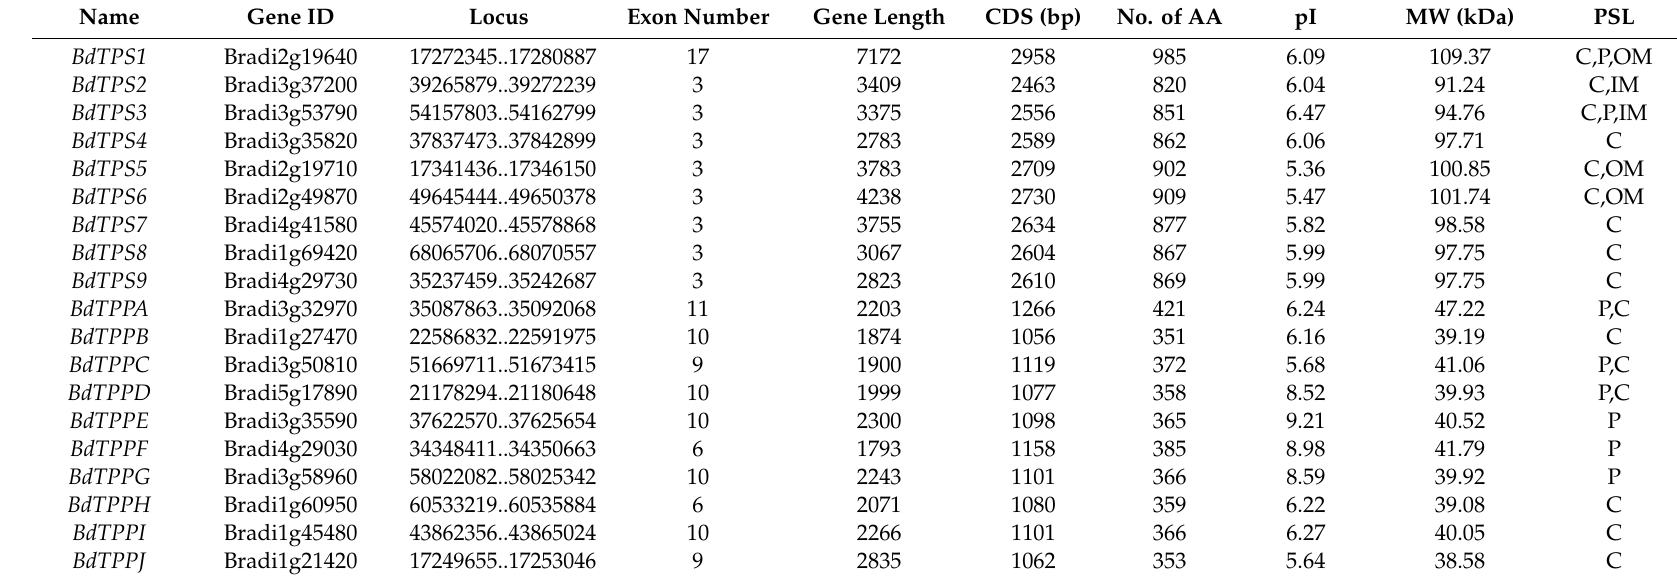
Table 1. Basic characteristics of TPS and TPP genes in Brachypodium